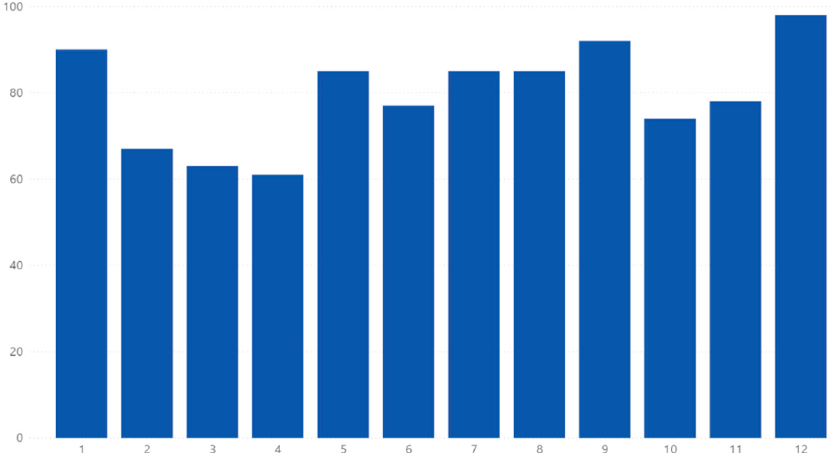
Figure 6. Number of fires per month of the year, where 1 is the 1st month, January, and 12th, the last, December.